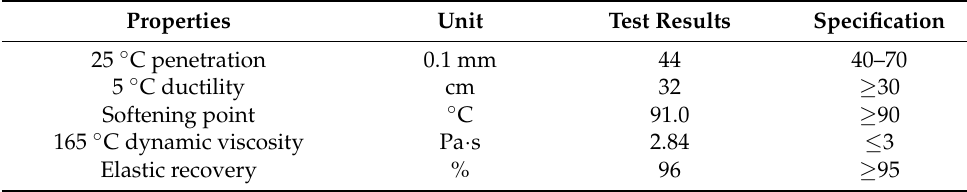
Table 1. Properties of